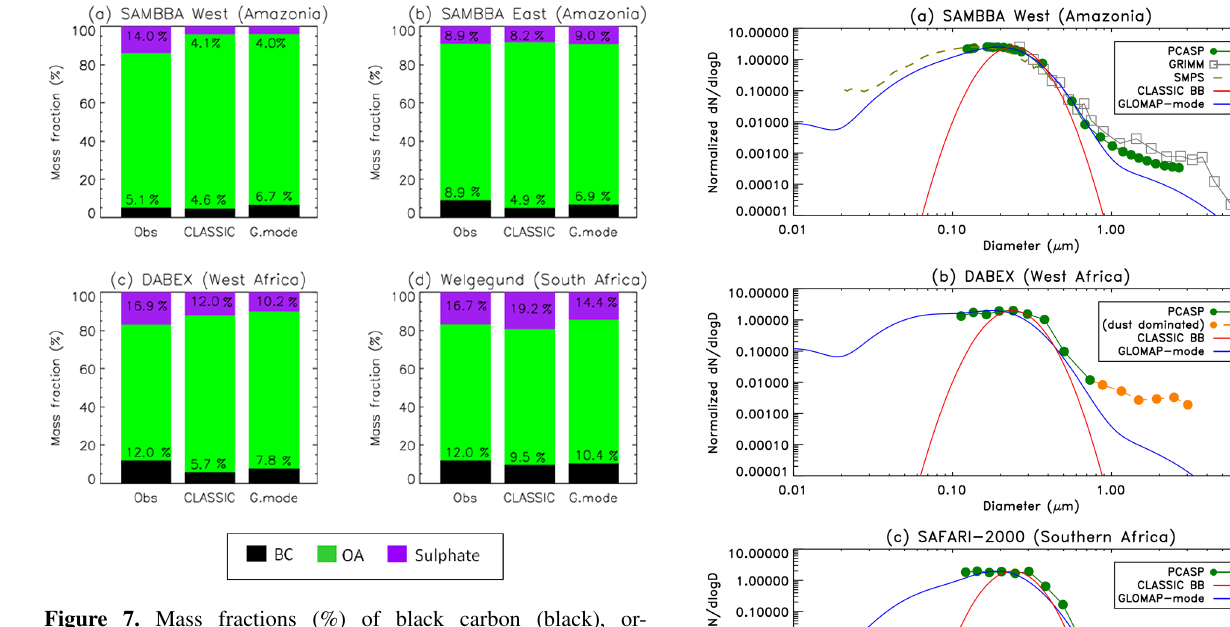
Figure 7. Mass fractions (%) of black carbon (black), or- ganic aerosol (green), and sulfate (purple) (excluding other fine- mode aerosol components). Observed data are monthly averages from field campaigns, including SAMBBA (Amazonia, September 2012), DABEX (West Africa, January 2006), and the Welgegund site (South Africa, September 2010). Modelled data are long-term monthly mean values corresponding to the month and location of the observations. Welgegund model data are for aerosol composi- tion at the surface (lowest model level); SAMBBA and DABEX model data are averaged over 0–5km. The BC and sulfate mass fractions are labelled on each bar.